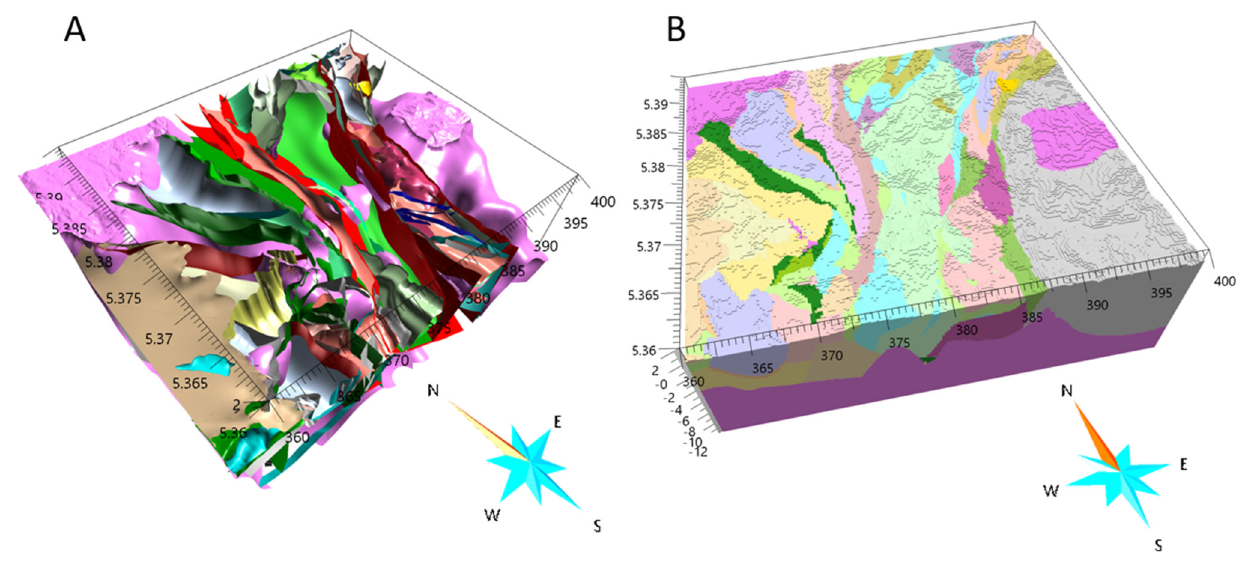
Figure 4. ( A ) 3D schematic of the Rosebery region illustrating the geological model lithologies. Notable features include granitoids (pink surfaces) and complex fault network architecture. The x- and y-axes are measured in meters east ( × 10 3 ) and north ( × 10 6 ), respectively. The z-axis is in kms. These axes measurements apply to subsequent models. ( B ) Discretized voxet reference model of the Rosebery region.